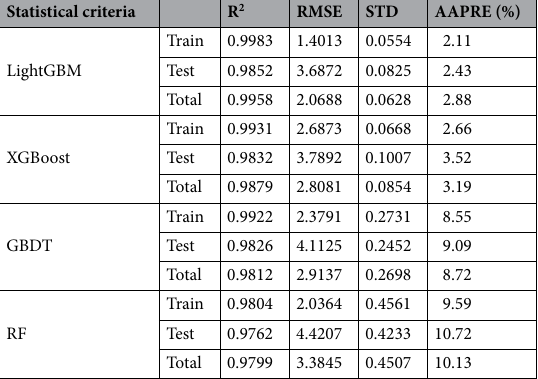
Table 2. Calculated statistical criteria for the developed models.